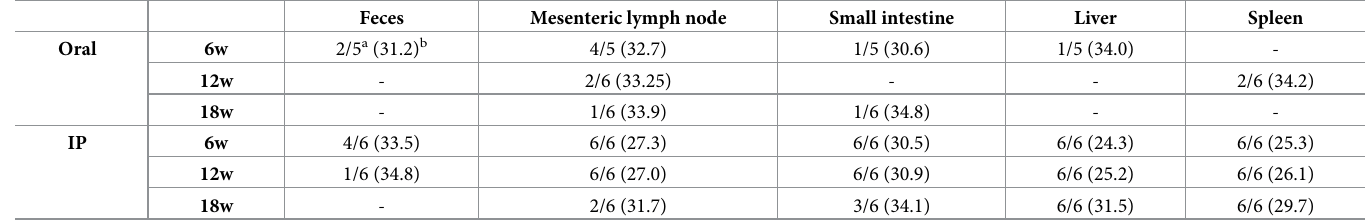
Table 1. Detection of bacterial DNA in different organs of mice infected with MAP by q-PCR